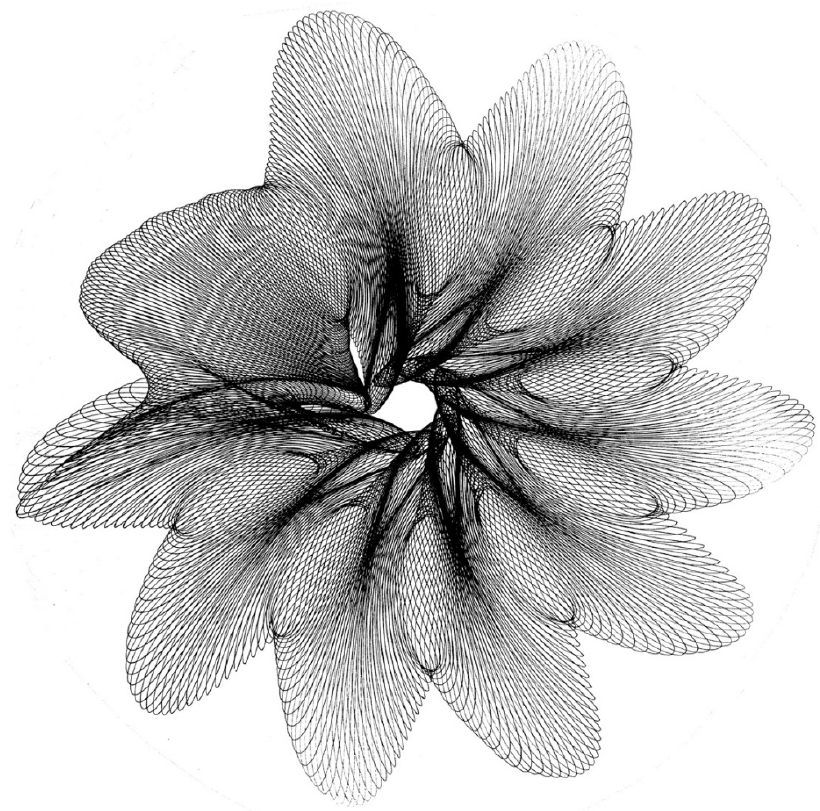
Figure 8. NTT image without pen-lift.